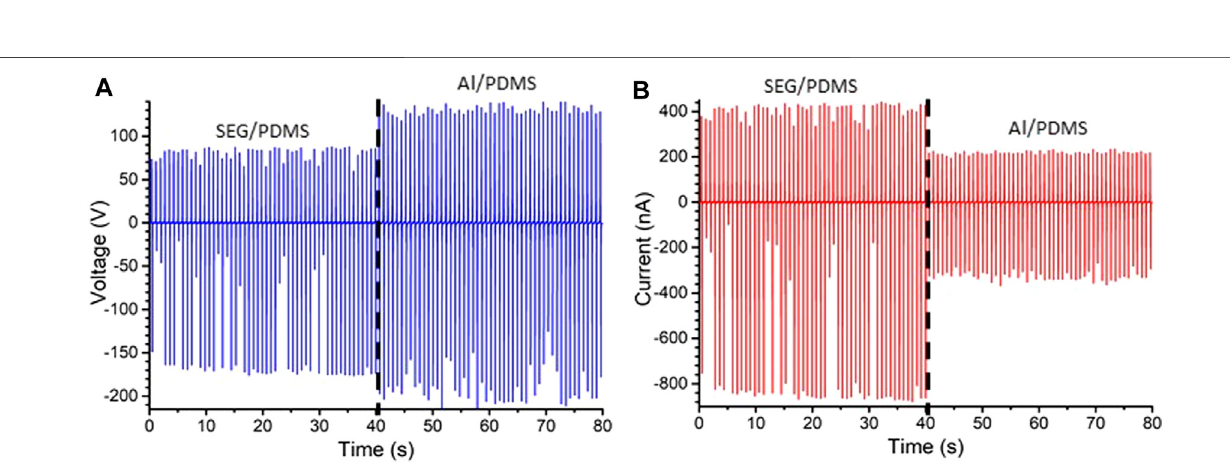
Frontiers in Physics |